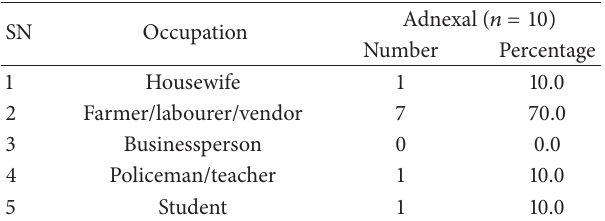
Table 3: Distribution of adnexal tumours according to the occupa-